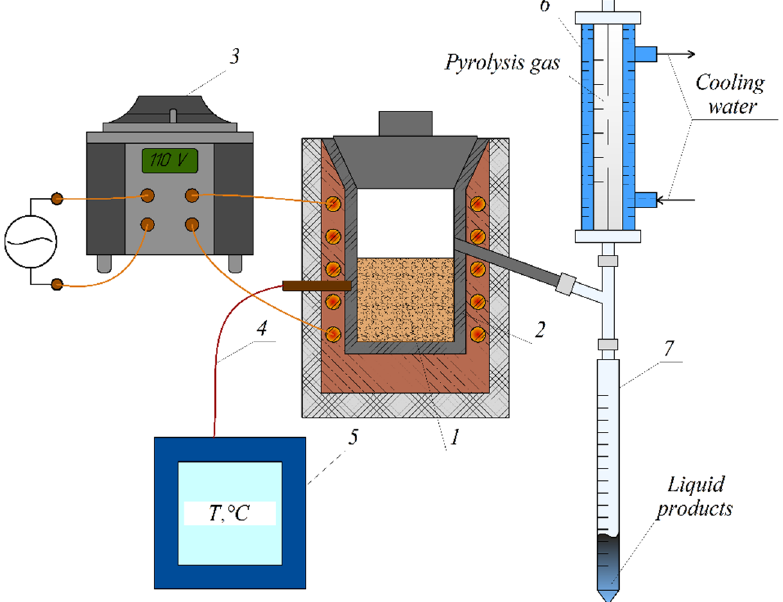
Figure 3. Laboratory device for measuring the yield of the liquid products in time: 1—Siberian pine nutshell, 2—reactor, 3—laboratory transformer, 4—high-precision multichannel temperature meter TM 5104 (Elemer, Moscow, Russia), 5—K-type thermocouple, 6—down-flow condenser, 7—gauged condensate collector.